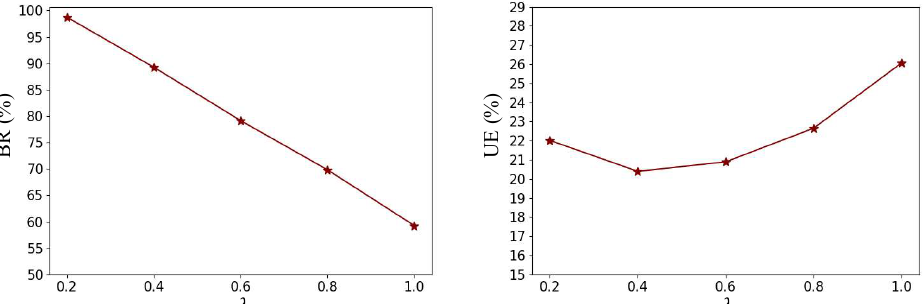
Figure 8. Quantitative comparison of superpixel generation results with different λ . ( left ) BR curves. ( right ) UE covers. ( K = 400 and v =